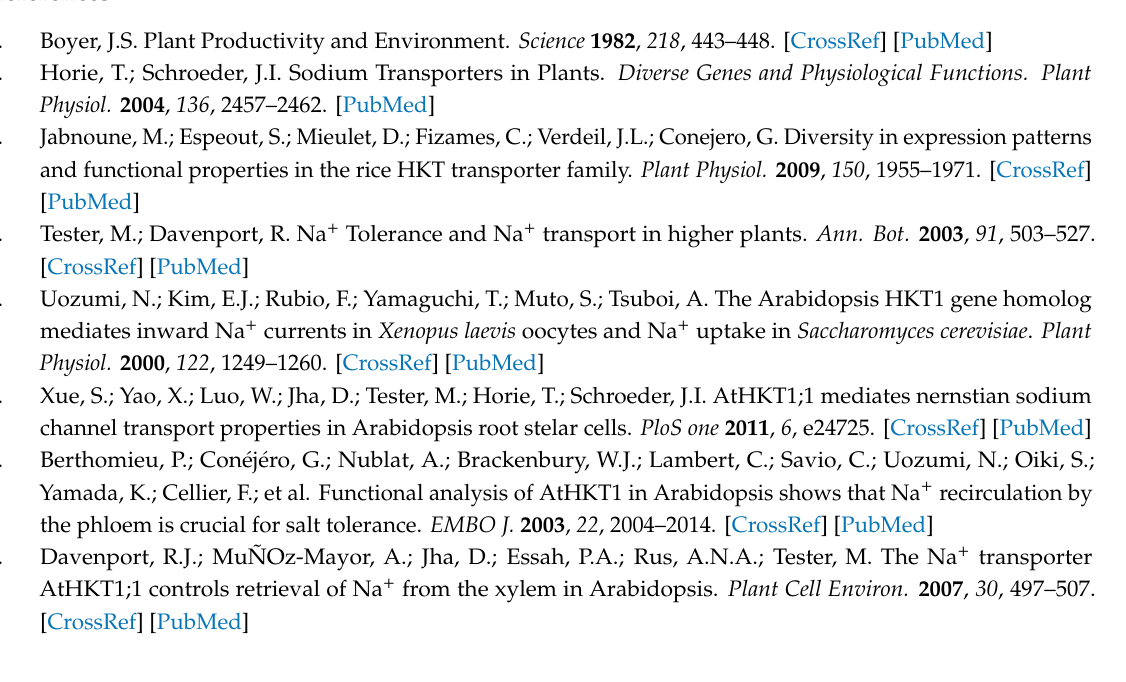
Figure S1: Histochemical analysis of GUS activity in AtHKT1;1pro – GUS transgenic lines under nonstress and salt-stress